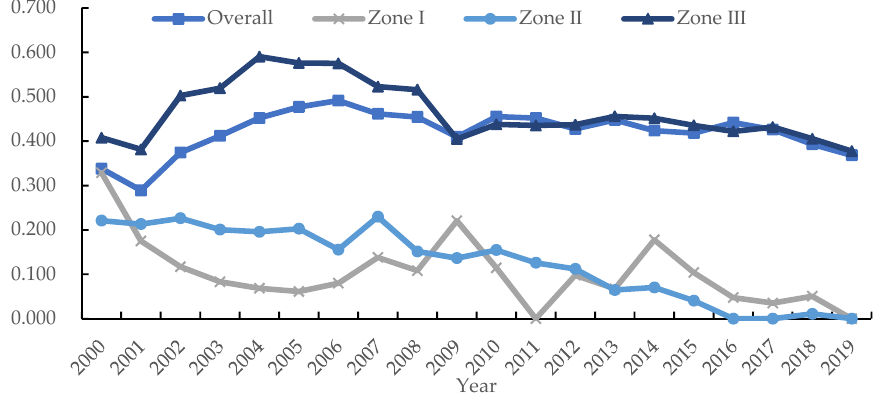
Figure 8. The σ -convergence test for the NCSPC in the principal grain-producing area of China from 2000 to 2019.